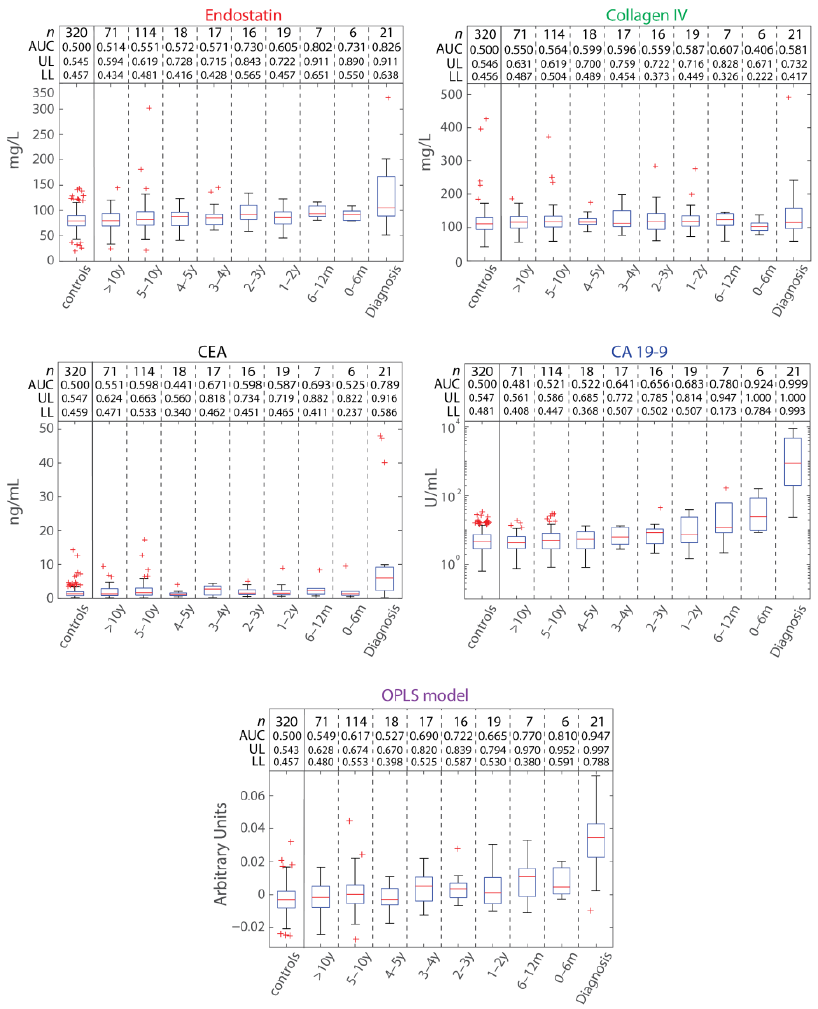
Figure 2. Separating future PDAC cases from controls in pre-diagnostic and diagnostic samples with a cross-sectional analysis. Box plots of the individual marker concentrations and OPLS-DA model scores (y-axes) for controls and (future) PDAC patients, indicating the median (red line), upper and lower quartiles (box), inter-quartile range (whiskers), and outliers (red cross). Controls and samples at diagnosis are categorized on the x-axis and pre-diagnostic samples are stratified in the x-axis according to time prior to diagnosis (0 – 6 months, 6 – 12 months, 1 – 2 years, 2 – 3 years, 3 – 4 years, 4 – 5 years, 5 – 10 years, and >10 years). The number of samples ( n ), area under the curve (AUC), as well as the 95% confidence interval (UL, upper limit; LL, Lower limit) values for each x-axis category are indicated.